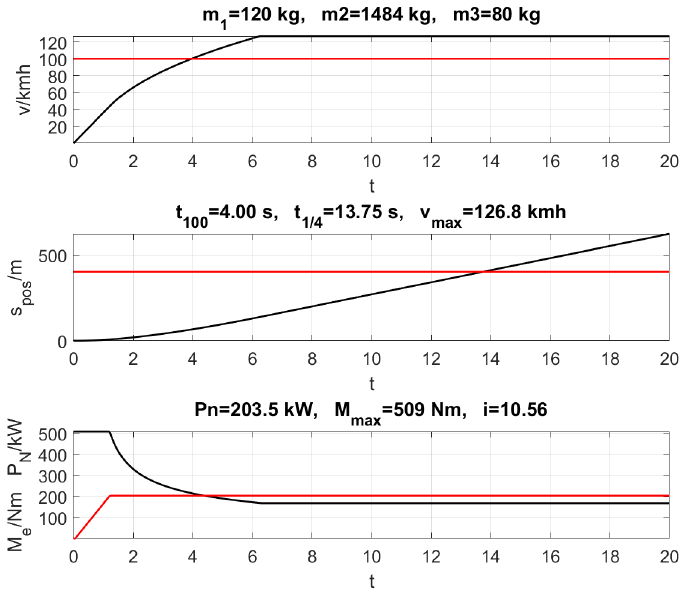
Figure 11. Optimized powertrain for 4 s acceleration to 100